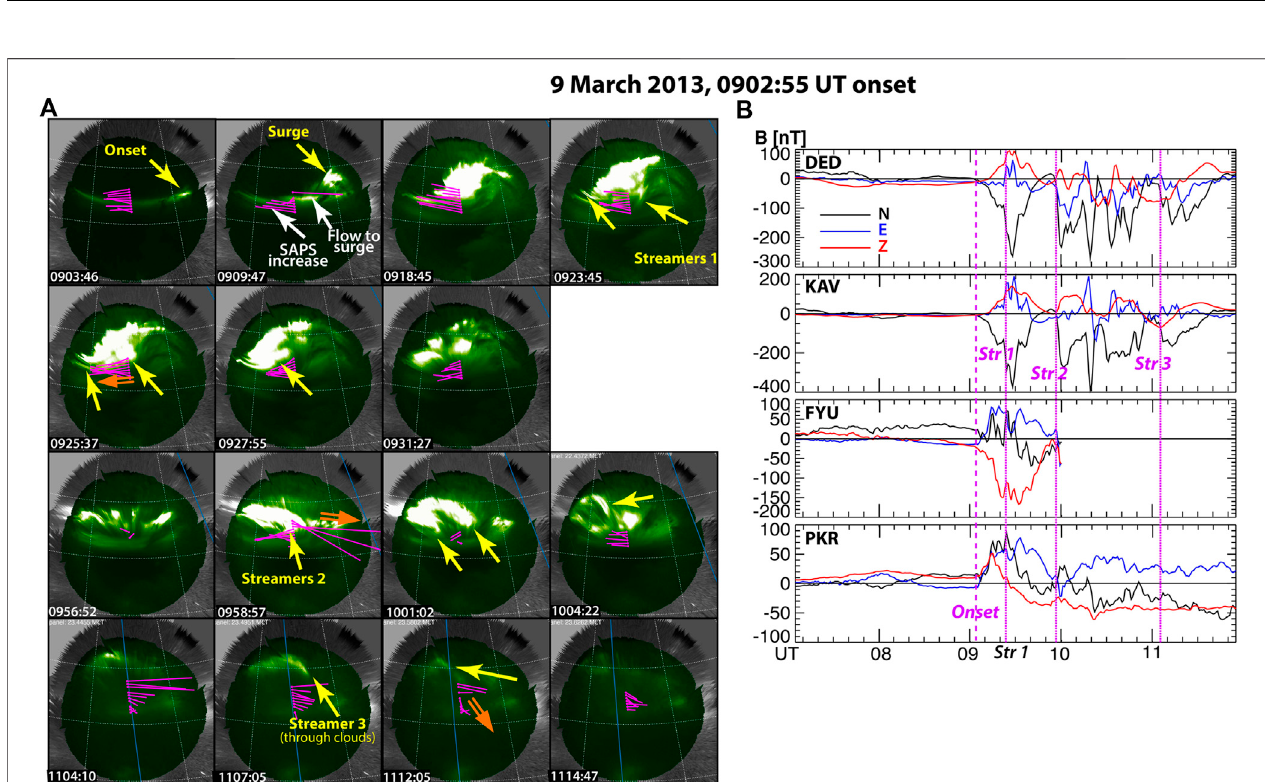
FIGURE 11 | Observations on March 9, 2013, during a period when PFISR was operating. (A) Poker Flat ASI 557.7 nm emissions with THEMIS ASI white light emissions in regions outside the Poker Flat ASI FOV overlaid with PFISR fl ow vectors along the radar magnetic meridian. (B) Ground magnetometer observations from stations approximately along the Poker Flat meridian stacked from lower to higher latitudes. “ Str ” is abbreviation for “ streamer. ” Yellow arrows point toward streamers, and orange arrows indicate observed streamer-related fl ows. Observations from the period before and during the fi rst streamer period are shown in the top two rows, and observations from the second and third streamer period are shown in the third and fourth rows, respectively.